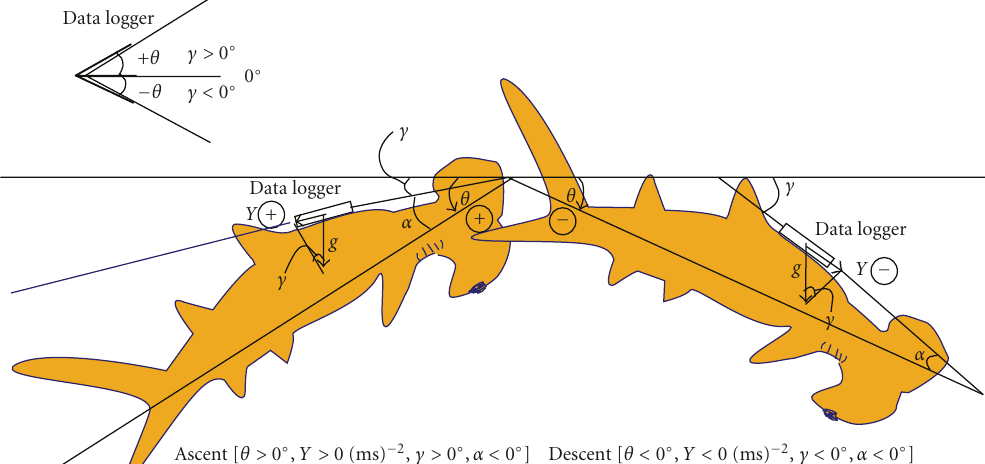
Figure 1: Attachment of a data-logger to the dorsal side of a hammerhead shark. Diagram shows the direction of surging acceleration Y , recorded by a D2GT logger placed on a shark, and gravity g ( = 9 . 8ms − 2 ), angle of surge axis of the logger to horizon ( γ ), that of longitudinal axis to horizon ( θ ) defined as pitch angle (negative as the shark descends), and logger attachment angle ( α ).